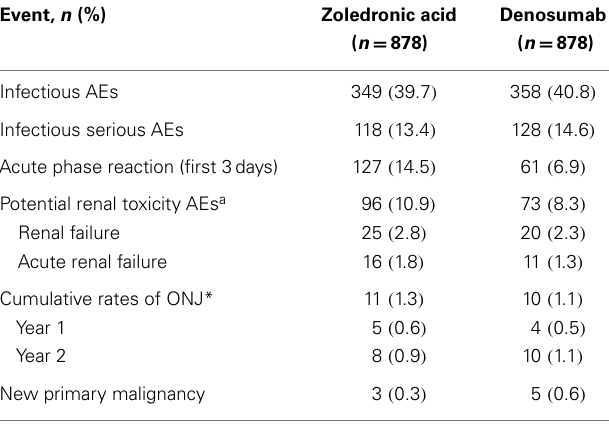
Table 2 |Adverse events of interest